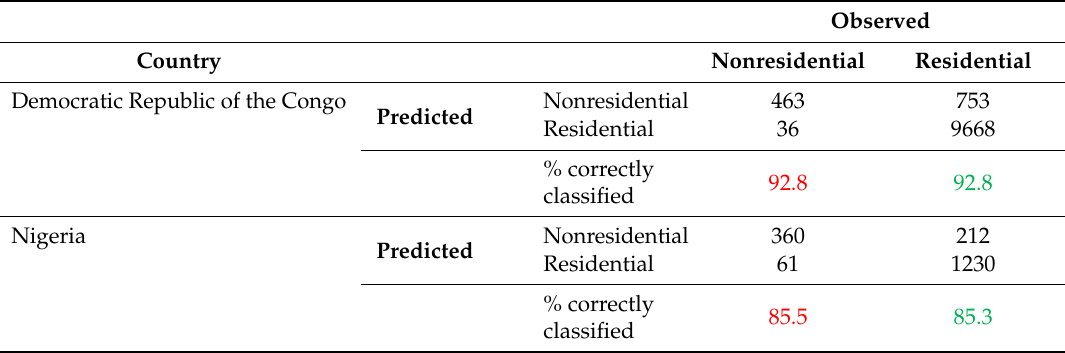
Table 3. Performance of the building classification superlearner models when applied to the test data. The sensitivity (recall, or true positive rate) of the respective models for the two countries are shown in green, the specificity (true negative rate) in red. Classifications were made using the country specific cut-off threshold at which CV-classification accuracy was equal for residential and nonresidential structures.